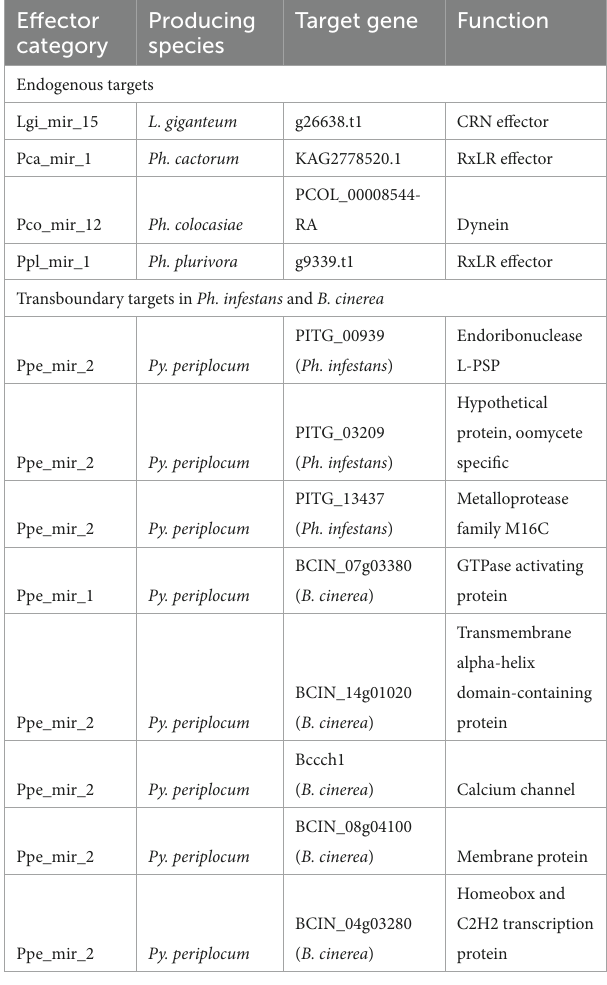
TABLE 3 Targets of interest predicted for the detected